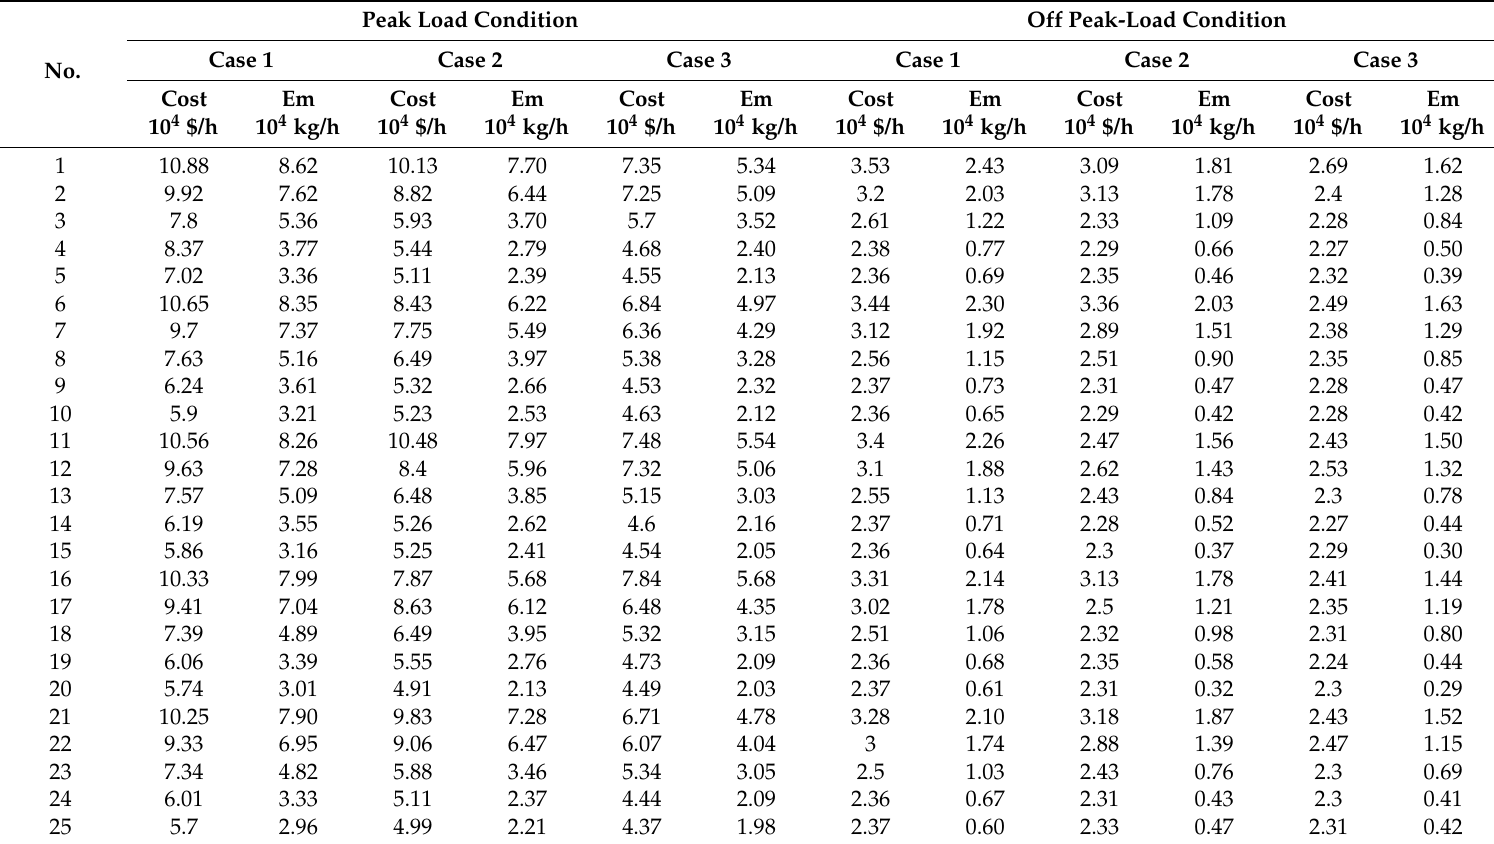
Table 3. Operation cost and emissions in different load